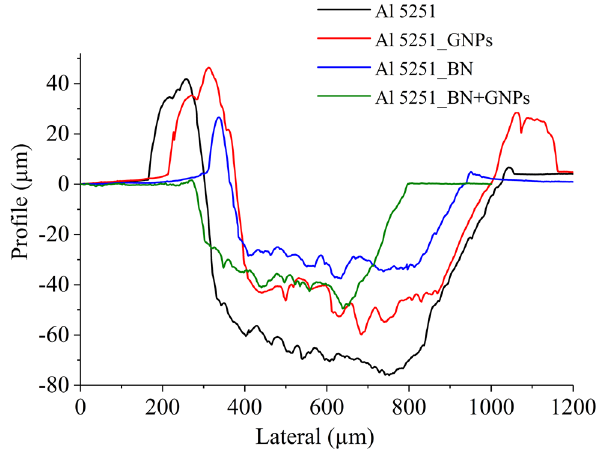
Figure 12: Wear pro fi le of the investigated samples under a constant load of 10 N.